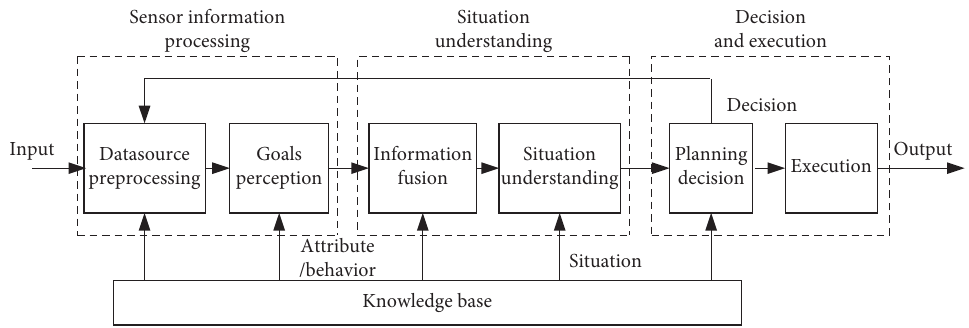
Figure 1: Information processing flow for UUV autonomous